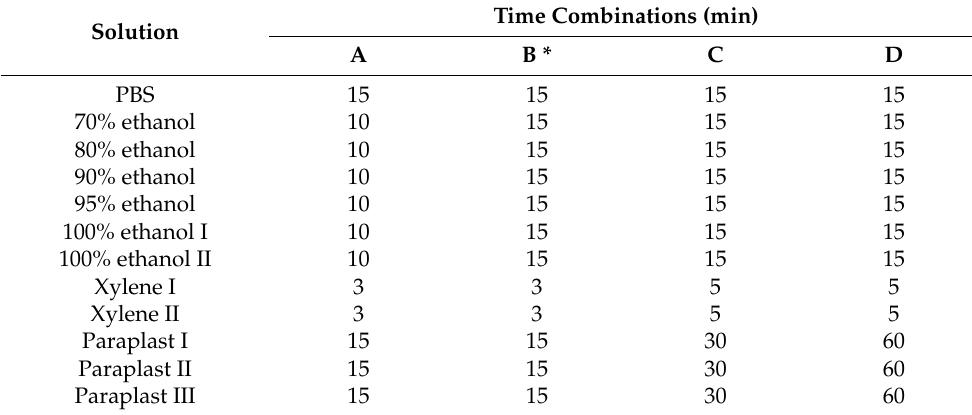
Table 1. Summary of procedures in paraplast processing.